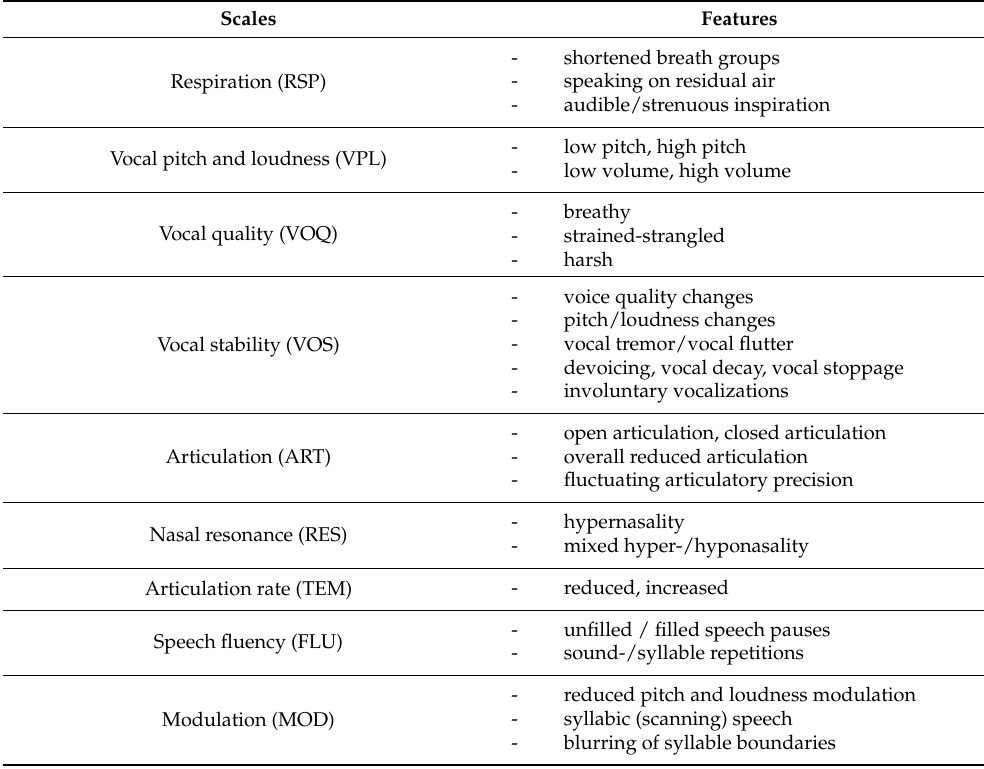
Table A1. BoDyS scales (left) and their associated features (right).